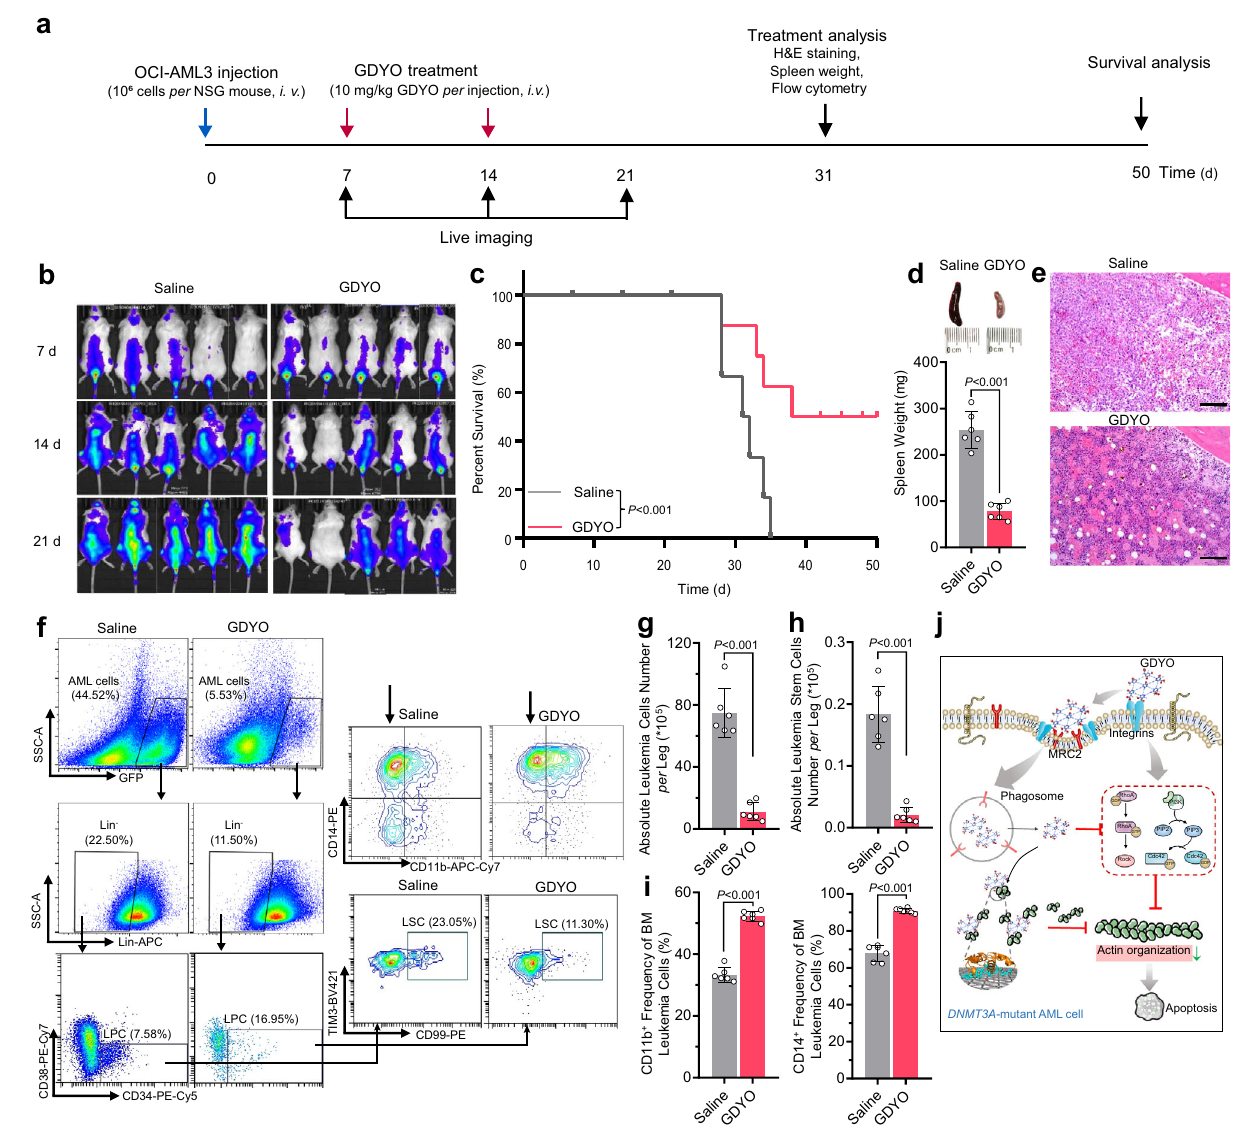
Fig. 6 | GDYO exhibited in vivo therapeutic potential against DNMT3A mutant AML cells. a Schematic illustration of the experimental design. b Representative IVIS spectrum images. n = 5 biologically independent animals. c Kaplan-Meier survival curve of AML mice injected with saline or GDYO. n =8 biologically inde- pendent animals . d Spleen weight of AML mice injected with saline or GDYO at sacri fi ce. n =6 biologically independent animals . e Bone marrow H&E sections of AML mice injected with saline or GDYO at sacri fi ce. Scale bar, 100 μ m. f Representative fl owcytometryimagesofBMtotalmononuclearcells. g-i Absolute